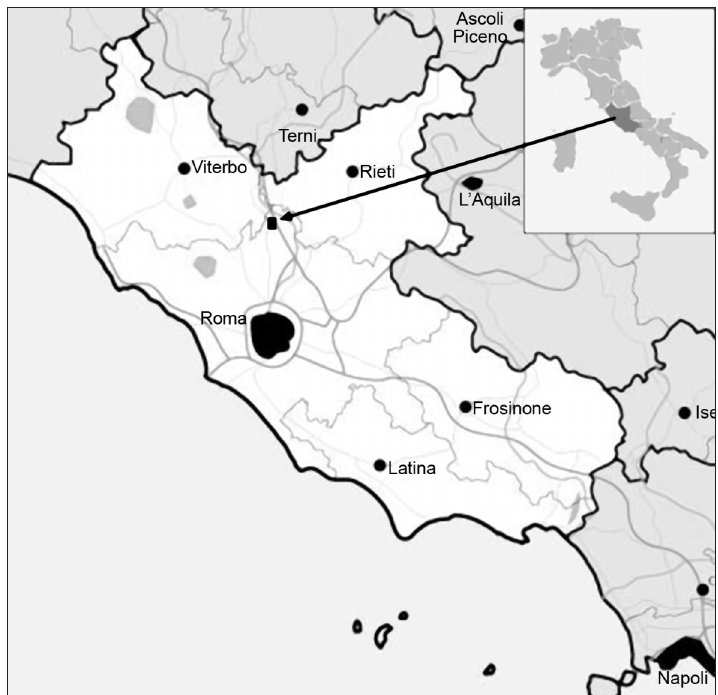
Fig. 1. Location of the study area. On the left the topographic map of the Soratte Mt. on a 1:10.000